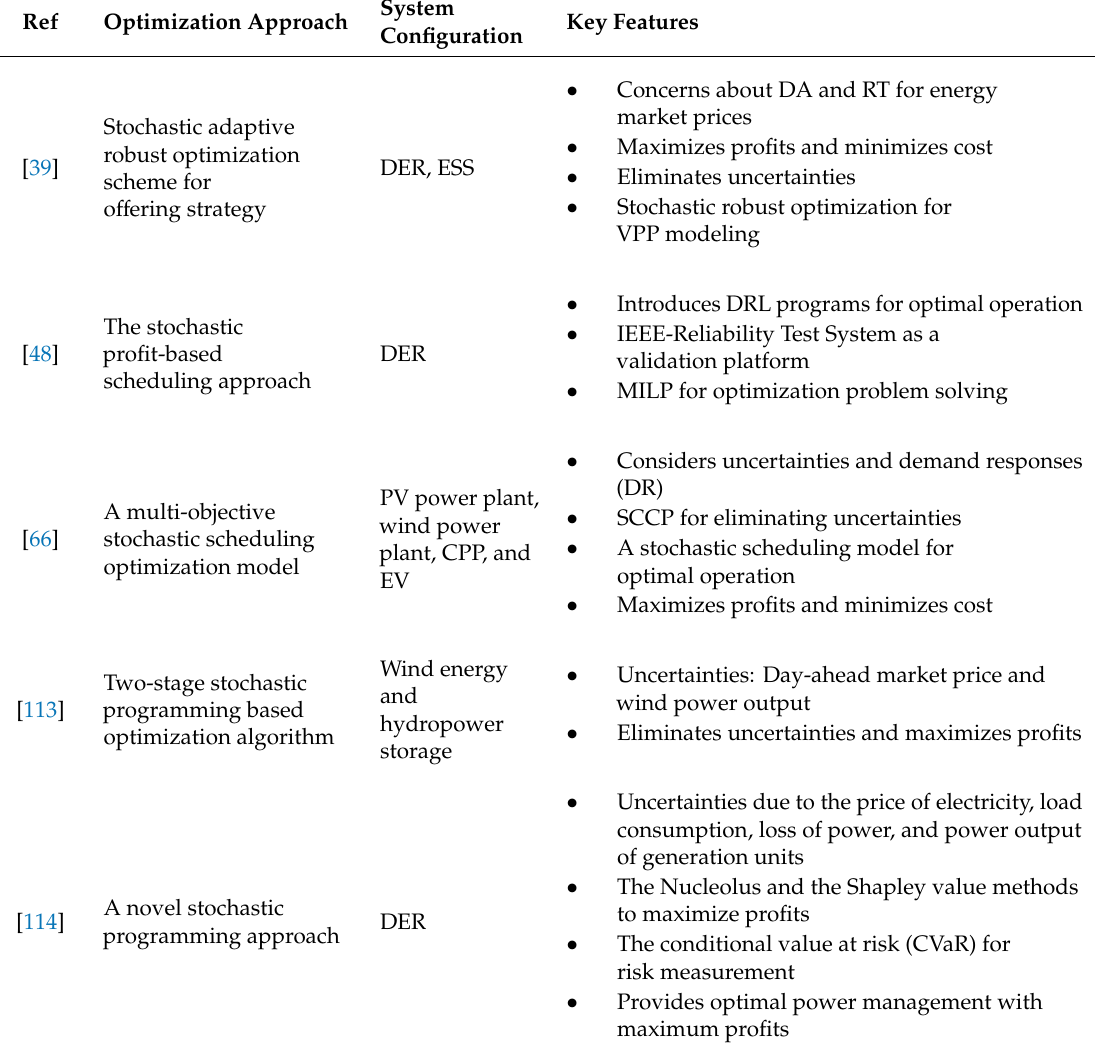
Table 7. A comparative analysis among di ff erent stochastic techniques for the virtual power